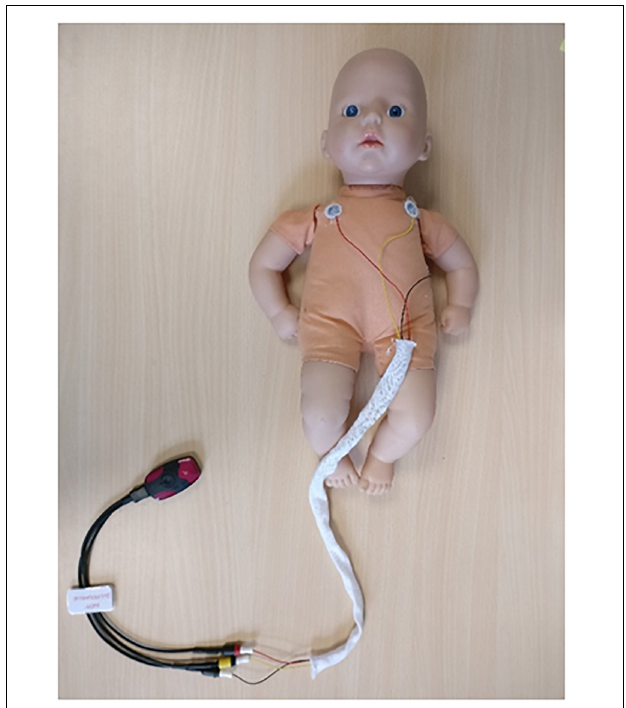
FIGURE 1 | Portable ECG recorder and thoracic setup. Three ECG electrodes were fed through an alignment sleeve to reduce the distance between ECG wires and prevent magnetic induction artifacts on raw ECG signal (500 Hz with automatic R-peak detection).